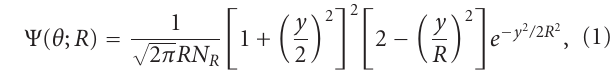
Figure 1: Figure shows the profile on the SMHW as a function of the angular distance θ for di ff erent wavelet scales R , ranging from 1 ◦ to 45 ◦ . Notice that the amplitude of the SMHW at θ ≡ 0 has been fixed to 1, to allow for an easier